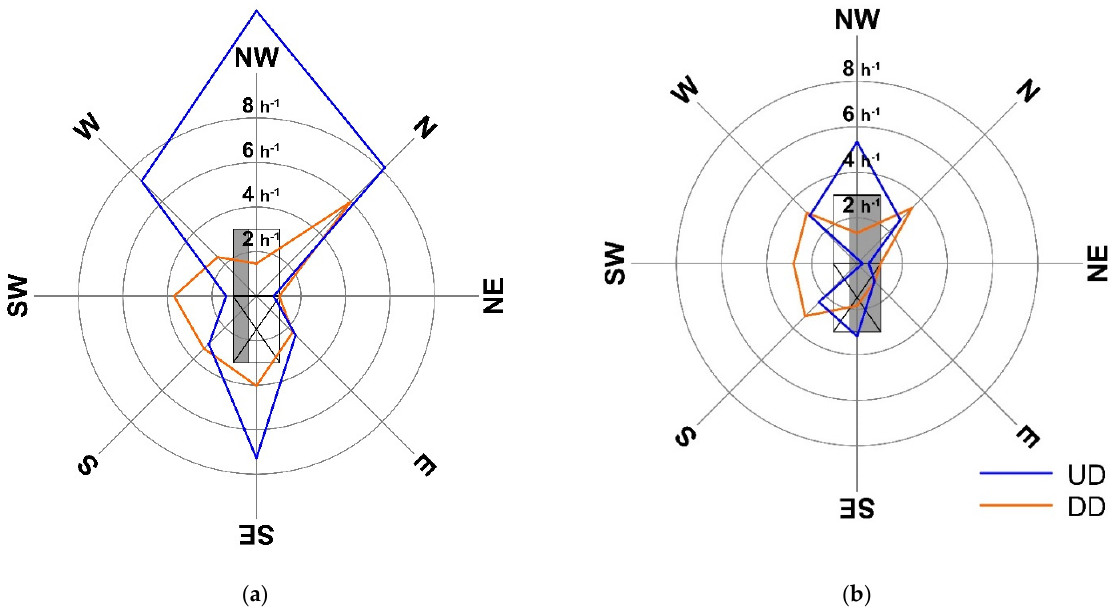
Figure 8. Results of air change per hour [h − 1 ] ( a ) in the cellar and ( b ) in the production hall where grey shows the mentioned area in the sematic figure of the building—Site A with less but closer neighbors.